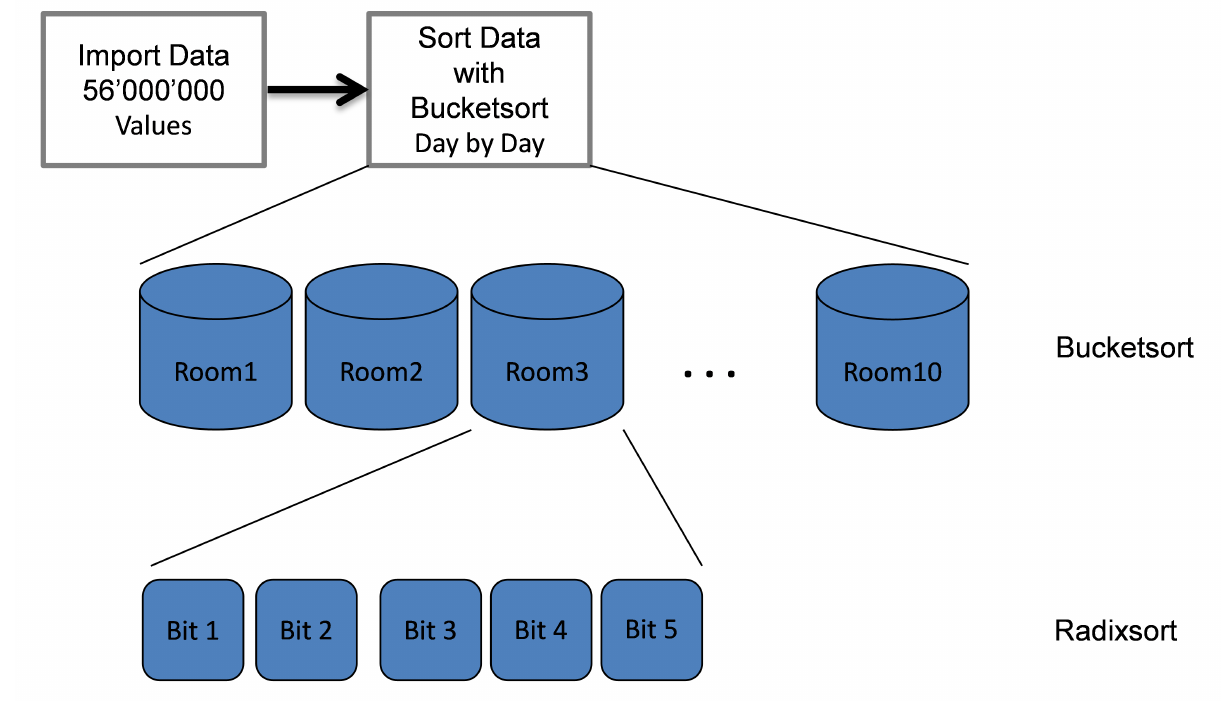
Figure 4. Combined sort algorithm consists of a Bucketsort and a Radixsort algorithm applied to the